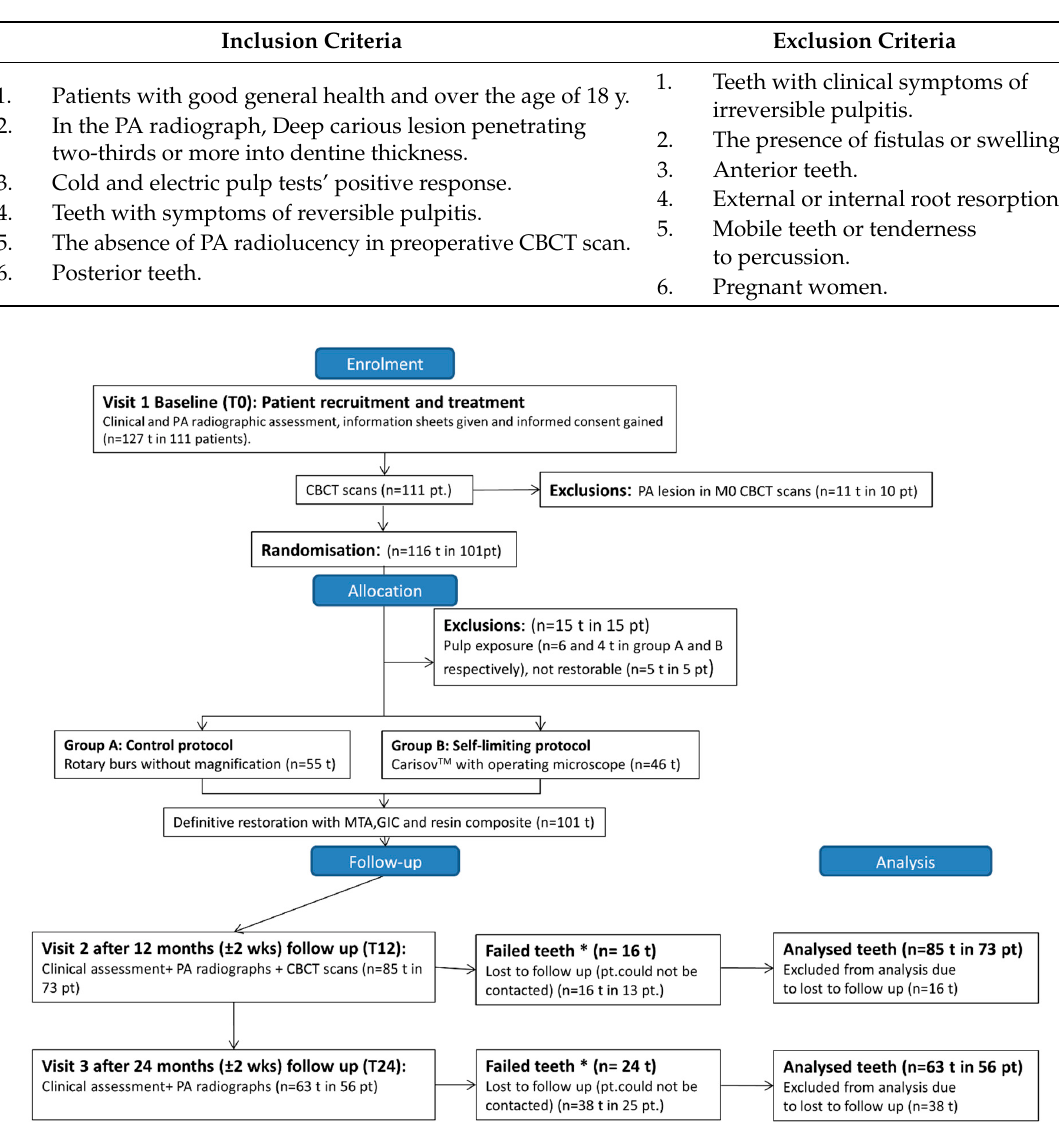
Table 1. Criteria for Inclusion and Exclusion of Patients.